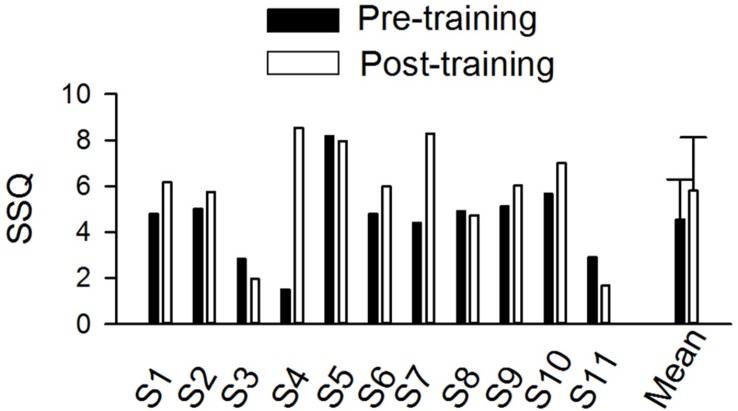
The pre- and post-training SSQ scores in individual subjects and the mean score of all individuals (n = 11). The error bar indicates 1 standard deviation.